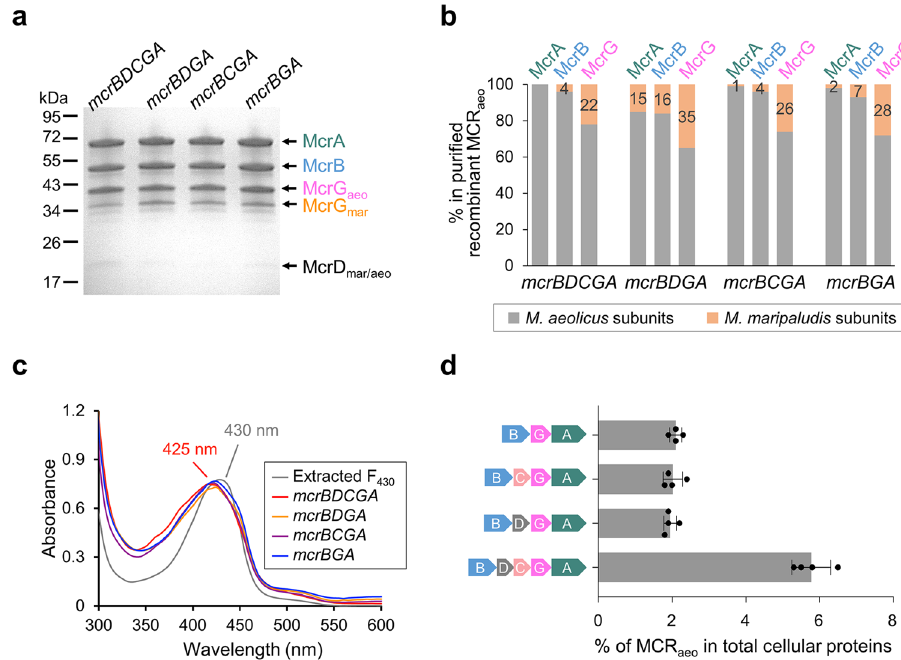
Fig. 4 Expression of recombinant MCRaeo with truncated operons. a SDS-PAGE analysis of the recombinant MCR aeo puri fi ed by Strep-tag af fi nity and ion-exchange chromatography. All constructs had a Flag-Strep 2 tag added to the N-terminus of McrG. The operon structures are labeled above each lane. The molecular weights based on standards are labeled on the left. All subunits were identi fi ed by MALDI-TOF MS and labeled on the right. b The relative abundance of M. aeolicus (in gray) vs. host M. maripaludis (in orange) MCR in each subunit of the co-puri fi ed complexes determined by LC-MS/MS. The percentages of M. maripaludis protein in total protein of each subunit are labeled. c UV – vis spectra of puri fi ed MCR aeo (all at 7.5 mg mL − 1 concentration) compared to coenzyme F 430 extracted from MCR. d Expression levels of recombinant MCR aeo determined by western blotting. Error bars represent the standard deviation of four independent